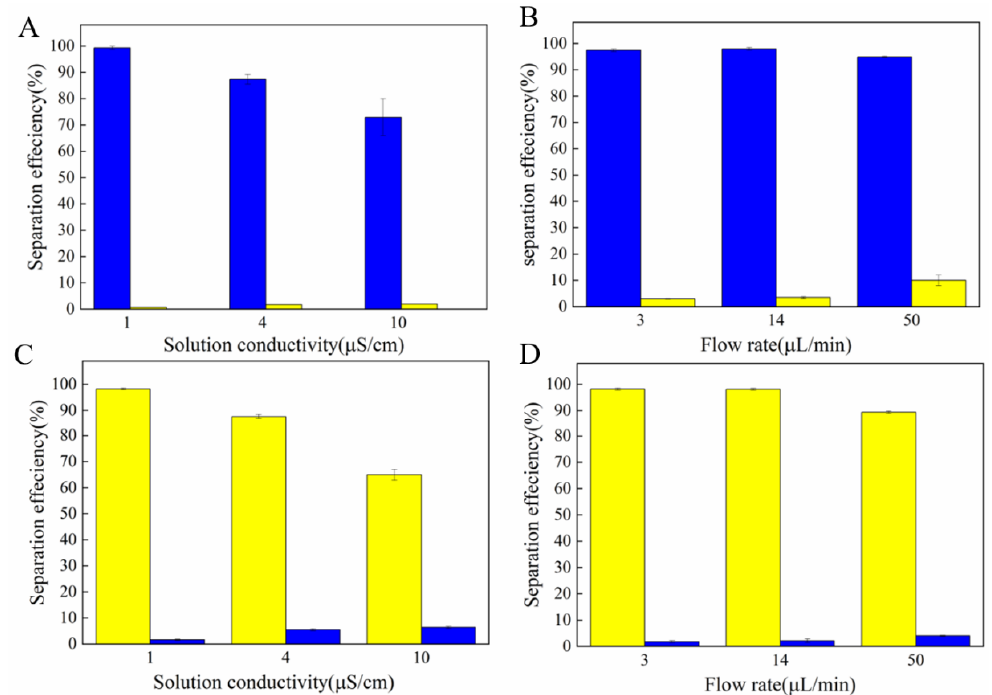
Figure 8. Statistics of separating efficiency under the parameters of different solution conductivities and flow rates. ( A , B ) Middle channel; ( C , D ) branch channels.